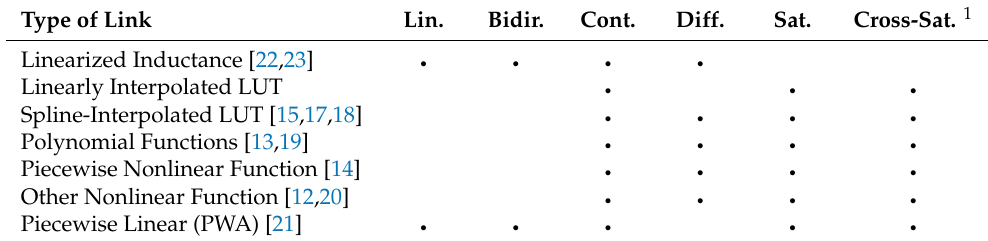
Table 1. Summary of offline MM linking